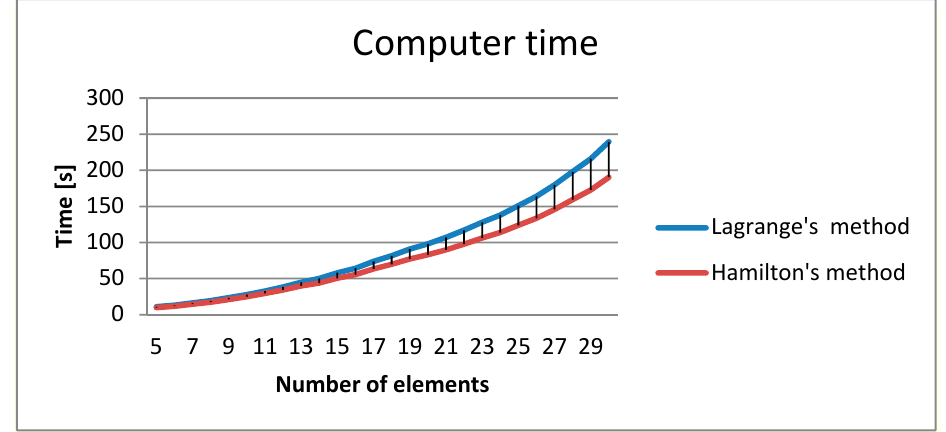
Figure 5. The computational time to integrate the motion equations in the two cases.